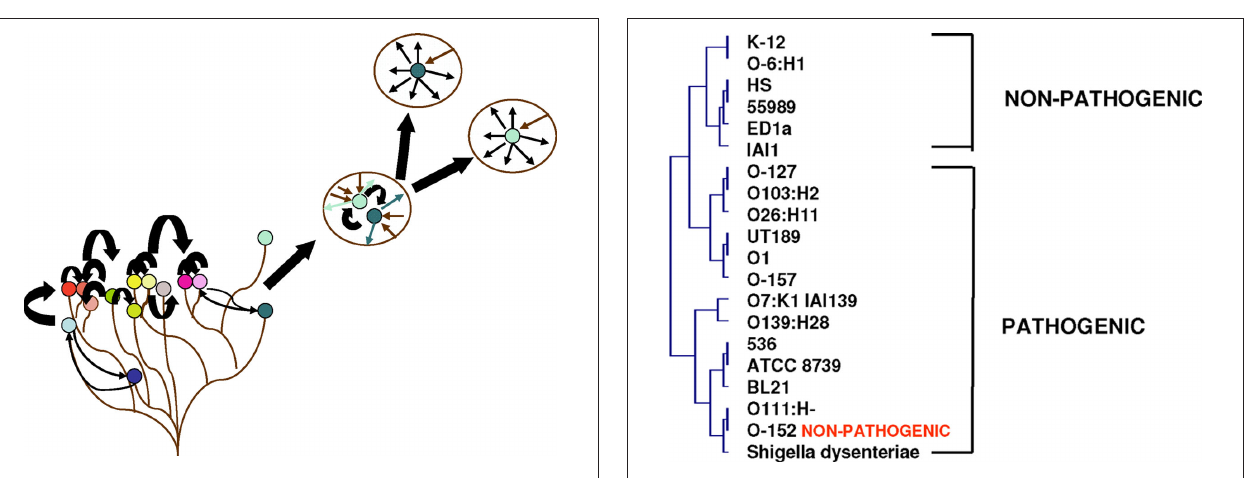
Figure 9 | Species complexes and the rise of specialists. Non-specialized bacteria form complexes and engage in high rates of gene exchange. Some specialists may emerge from a complex and progressively adapt a balance between gene gain and gene loss (favoring gene loss). The more specialized a species is, the more important genome reduction becomes. This limits its capacity to obtain new characteristics.